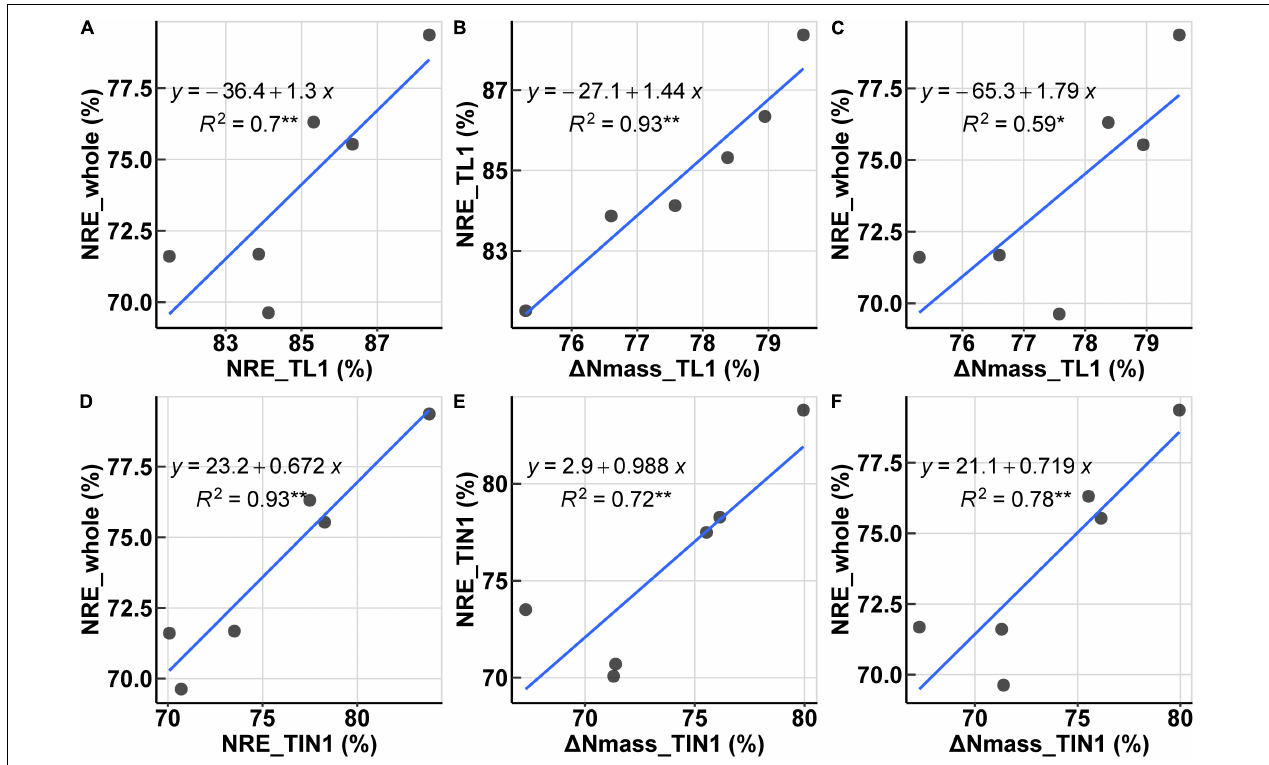
FIGURE 5 | Relationships of N remobilization-related traits. (A,D) Relationships between NRE of separated organs and the whole plant. (B,E) Relationships between nitrogen concentration change ( (cid:49) N mass ) and organ NRE. (C,F) Relationships between organ (cid:49) N mass and whole-plant NRE. (A–C) are for TL1 and (D–F) are for TIN1.